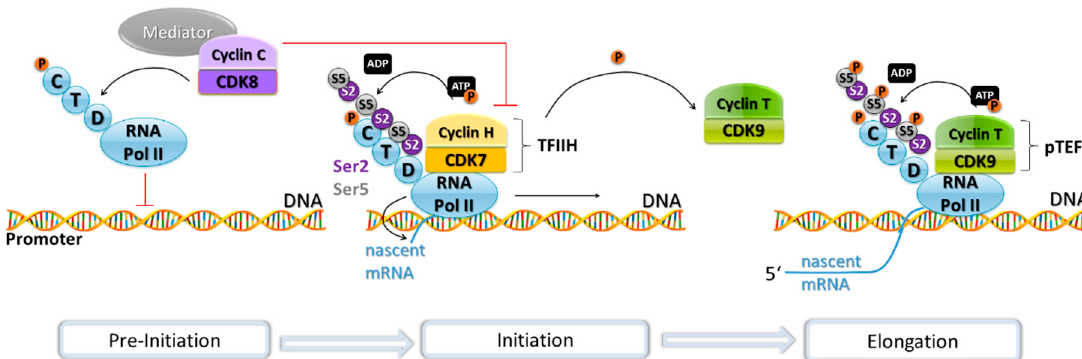
Figure 2. Transcription and its associated CDK/cyclin complexes. RNA Pol II forms part of the pre-initiation complex that starts gene transcription in eukaryotes. This pre-initiation complex is inhibited by the Mediator complex, of which CDK8 and cyclin C are part. The Mediator complex represses transcription by phosphorylating the C-terminal domain (CTD) of RNA Pol II to prevent its recruitment to the promoter and by phosphorylating cyclin H. Cyclin H in complex with CDK7 forms part of the transcription factor complex TFIIH, which in turn phosphorylates the CTD of RNA Pol II, triggering the transition from transcription initiation to mRNA elongation. TFIIH phosphorylates cyclin T as well. The CDK9/cyclin T complex forms part of the positive transcription elongation factor b (pTEFb), which phosphorylates the RNA Pol II CTD, thus promoting the extension of the pre-mRNA. CDK9 promotes phosphorylation of RNA Pol II as a subunit of the positive